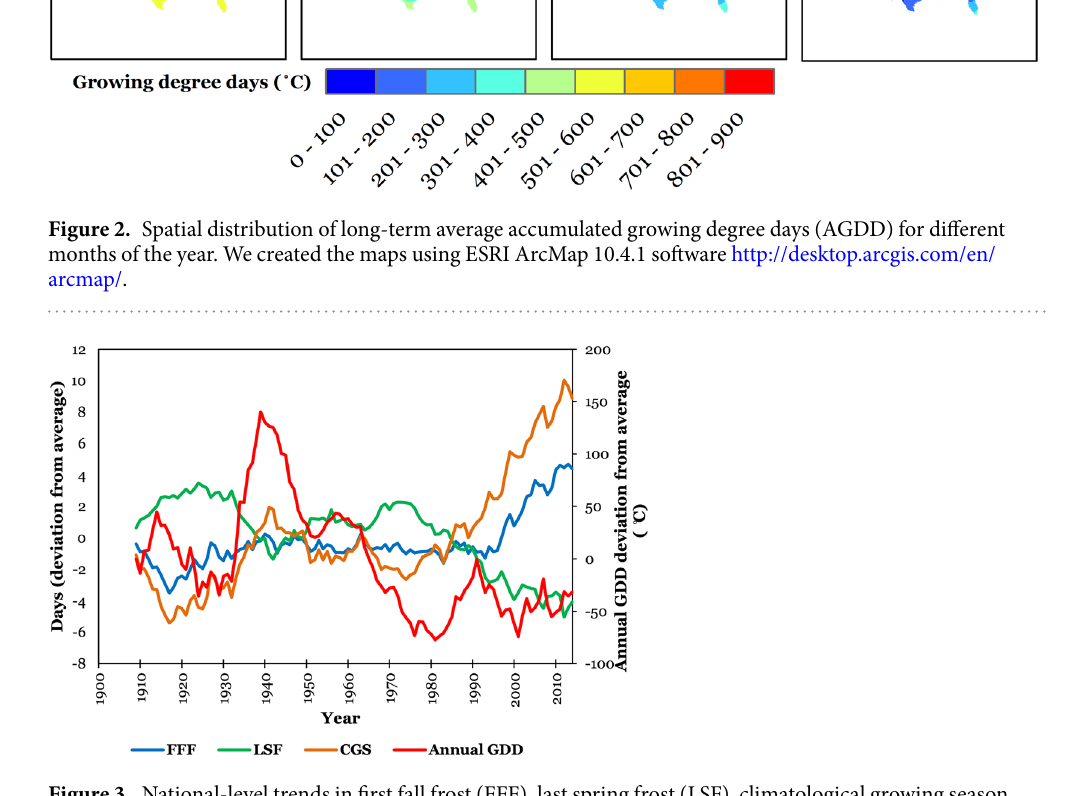
Figure 3. National-level trends in first fall frost (FFF), last spring frost (LSF), climatological growing season (CGS) and annual accumulated growing degree days (AGDD). The trends are shown using deviation of each series from average from 1900–2014. Each series represents a 10-year running